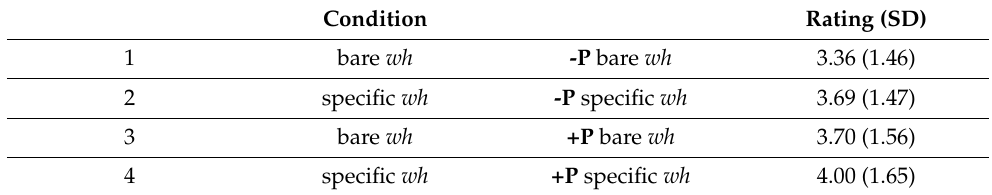
Table 2. Mean acceptability ratings in Experiment 1.